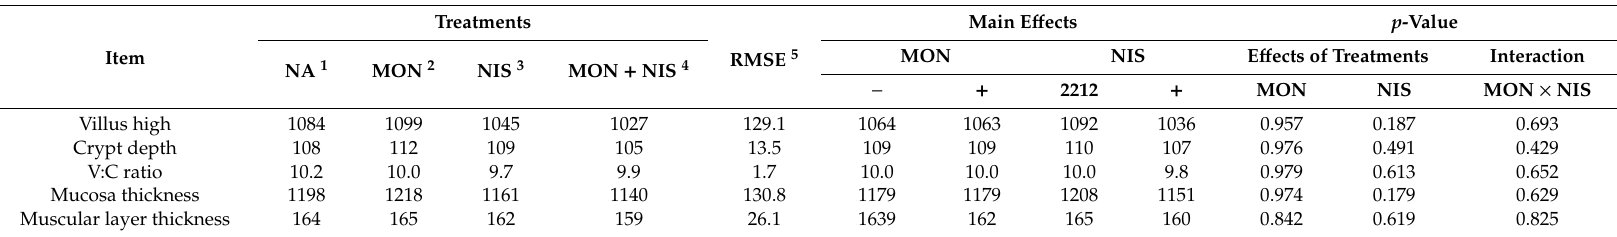
Table 8. The e ff ect of dietary supplementation of nisin alone or in combination with monensin on ileal histomorphology ( µ m) of broiler chickens, Experiment